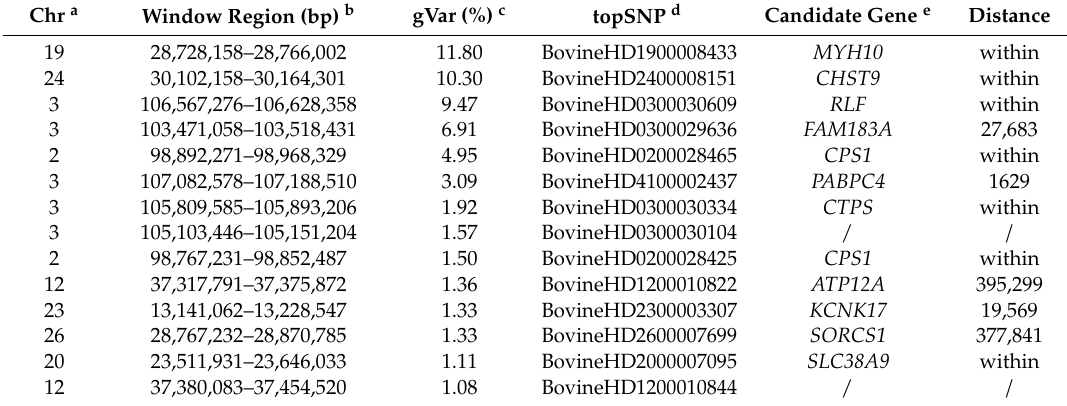
Table 3. Windows that explained > 1% of the additive genetic variance for yearling weight in Simmental beef cattle.